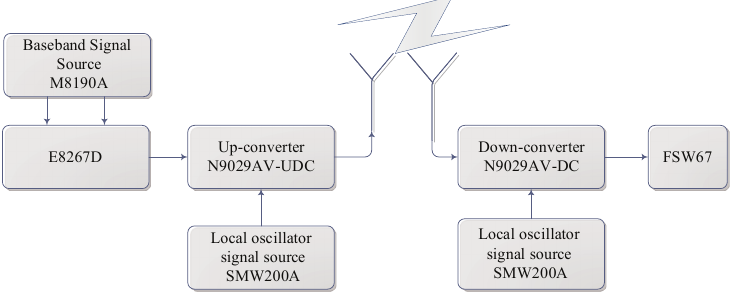
Figure 3. Commercial indoor millimeter wave system diagram.